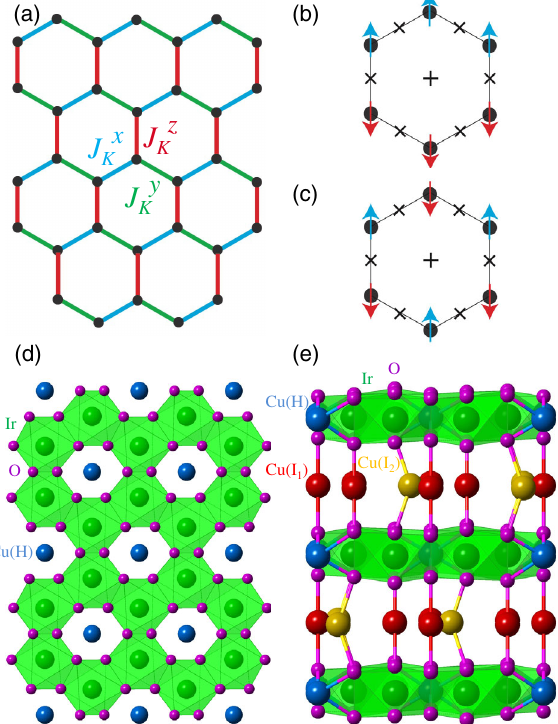
FIG. 1. (a) Kitaev lattice of effective spin S ¼ 1 = 2 (represented by bullets) at the corners of a honeycomb structure. Each spin interacts with three neighboring spins with Ising interactions J x K (blue bonds), J y K (green bonds), and J z K (red bonds). The frustration effects between the bonds lead to formation of Kitaev quantum spin liquid. Possible long-range ordering patterns of Ir spins [6,7] in (b)zigzagand(c)N´eelstructure. þ symbolsshowthelocationofthe Cu(H) sites, while × symbols indicate the approximate location of Cu ð I 1 Þ sites above or below the honeycomb planes. (d) Honeycomb lattice formed by Ir 4 þ ions in Cu 2 IrO 3 , viewed along the crystal c (cid:2) axis. Each Ir 4 þ (green) is surrounded by six O 2 − ions (purple) at the cornersofanoctahedron.Cu þ ð H Þ (lightblue)isatthecenterofeach iridium hexagon. (e) Side view of the Ir 4 þ planes viewed along the crystal a axis, with the interplanar Cu þ ð I 1 Þ (red) and Cu þ ð I 2 Þ (yellow) sites. O-Cu ð I 1 Þ -O bond is straight, whereas O-Cu ð I 2 Þ -O bond is buckled.